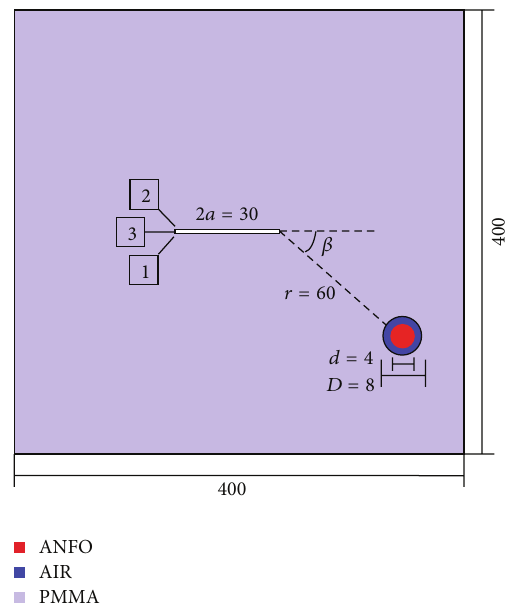
Figure 5: Schematic of blasting models, where 𝑎 is the crack length, 𝐷 is borehole diameter, 𝑑 is the ANFO diameter, 𝑟 is the distance from borehole center to crack tip, and 𝛽 ranges from 0 ∘ to 75 ∘ , the units being mm.